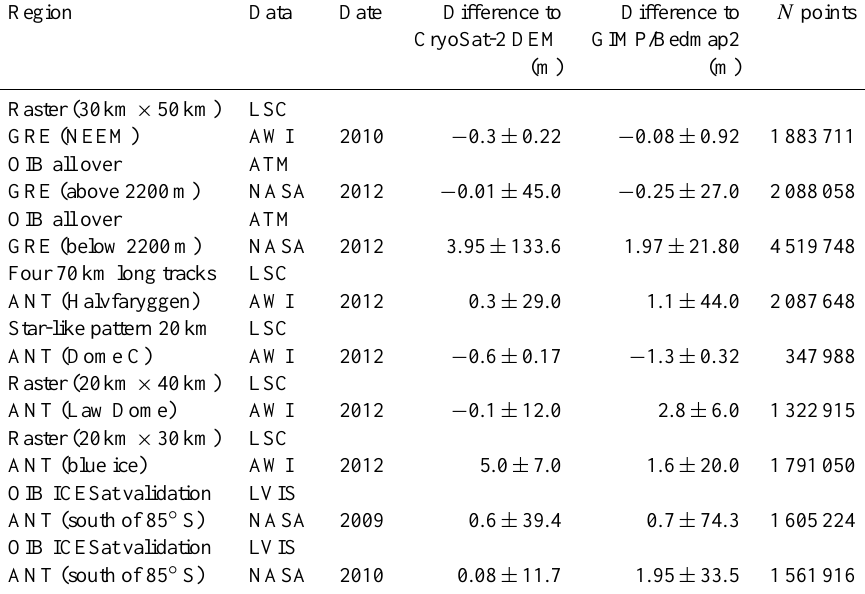
Table 2. Comparison of airborne laser altimetry data with the new CryoSat-2 DEMs and the GIMP DEM for Greenland (GRE) (Howat et al., 2014) and Bedmap2 DEM for Antarctica (ANT). (Fretwell et al., 2013). Laser data were acquired with the NASA Airborne Topographic Mapper instrument and/or the Land Vegetation and Ice Sensor (LVIS) during Operation Ice Bridge (OIB) missions by NASA. Laser scanner data (LSC) were acquired by the Alfred Wegener Institute (AWI) using a RIEGL LMS VQ-560 instrument.